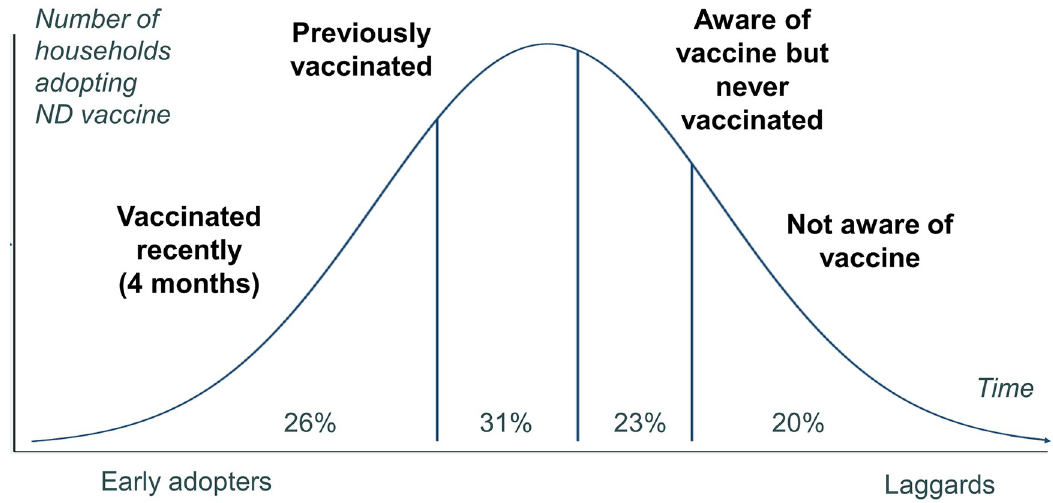
Fig 2. Stages of adoption. Proportions of households in four categories of adoption across all study sites.